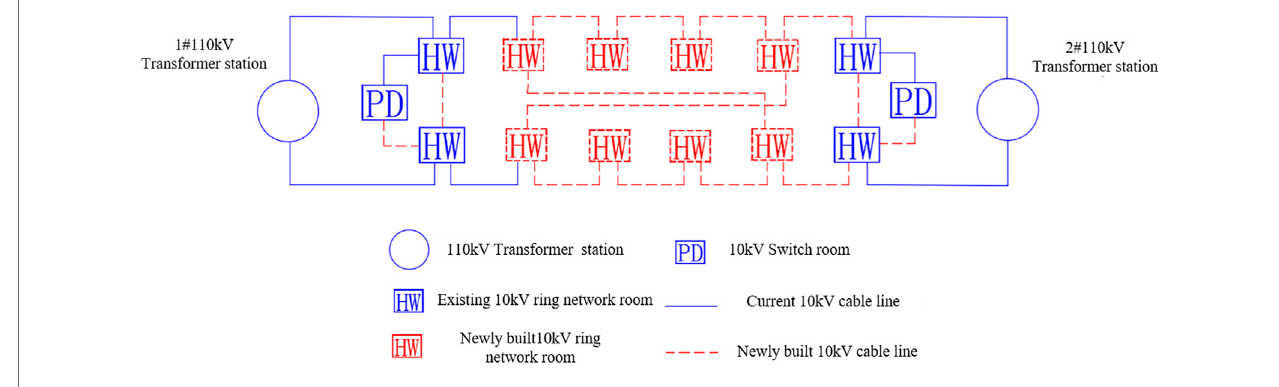
FIGURE 11 | The fourth wiring mode modi fi cation plan.